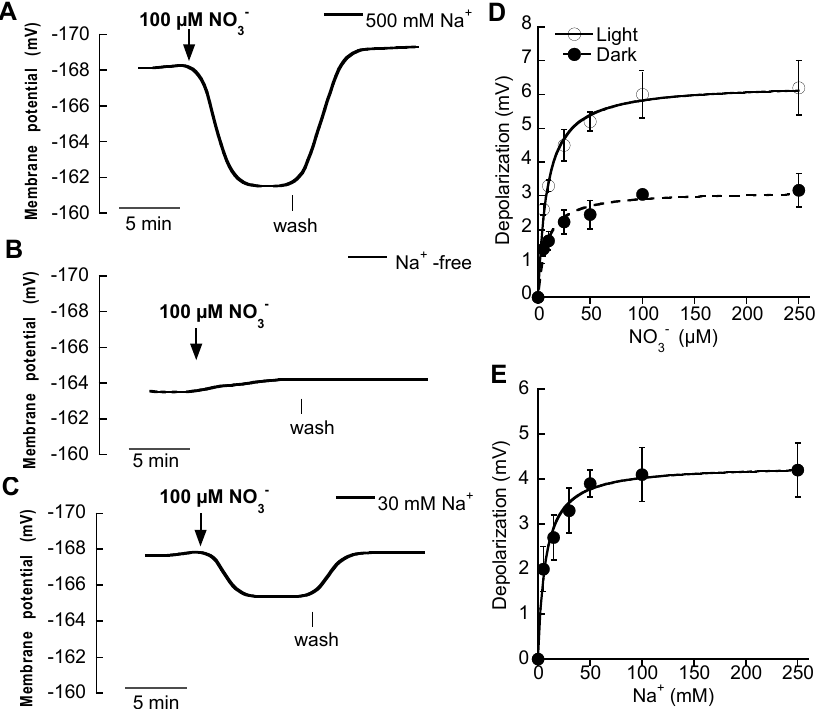
Figure 1. Effect of the addition of micromolar NO 3 − concentrations on the membrane potential of P. oceanica mesophyll leaf cells. Membrane potential changes after of the addition of 100 μ M NO 3 − (downward arrow) in ( A ) ASW containing 500 mM NaCl, ( B ) in Na + -free ASW and ( C ) in ASW containing 30 mM NaCl. Vertical lines indicate onset of NO 3 − wash. ( D ) Mean values of membrane potential depolarizations induced by increasing NO 3 − concentrations in ASW containing 500 mM Na + under light (open symbols) or dark (closed symbols) conditions. ( E ) Mean values of membrane potential depolarizations induced by the addition of 100 μ M NO 3 − in ASW containing increasing Na + concentrations. In D and E data were fitted to the Michaelis-Menten equation and kinetics parameters are shown in Table 2. Values are the means ± SD of five independent replicates.